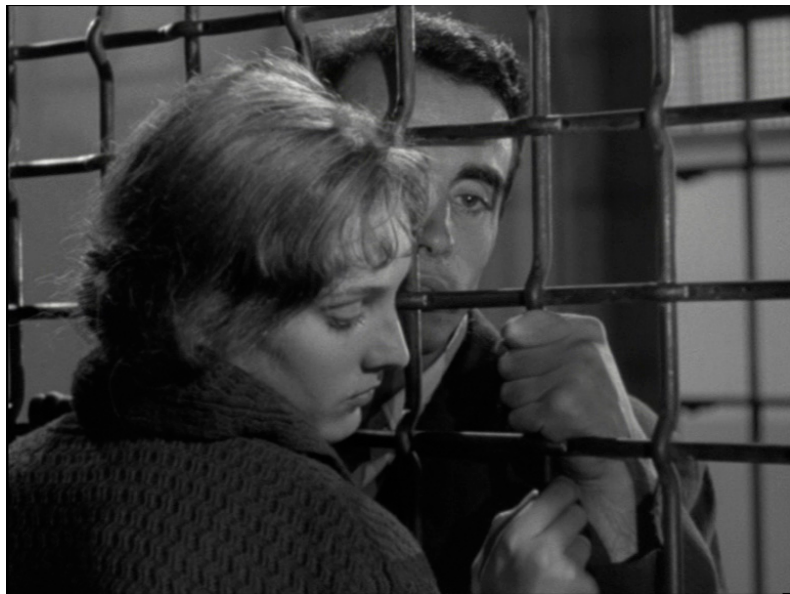
Figure 5. End of a strange path. Source Artificial Eye: ART 295 DVD.